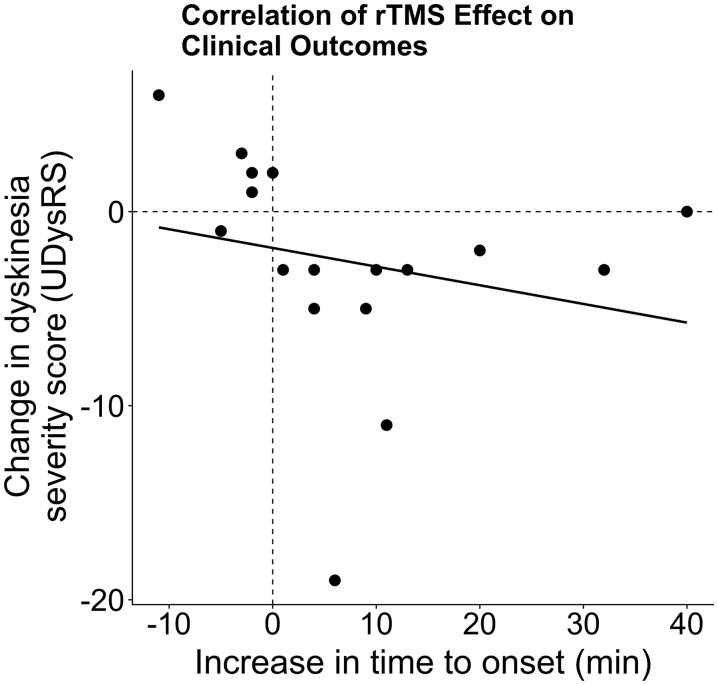

Correlation of changes in clinical outcome measures after real-rTMS. Across the group, increases in time to onset were significantly correlated with decreases in dyskinesia severity (r = 0.72, P = 0.002). UDysRS, Unified Dyskinesia Rating Scale.